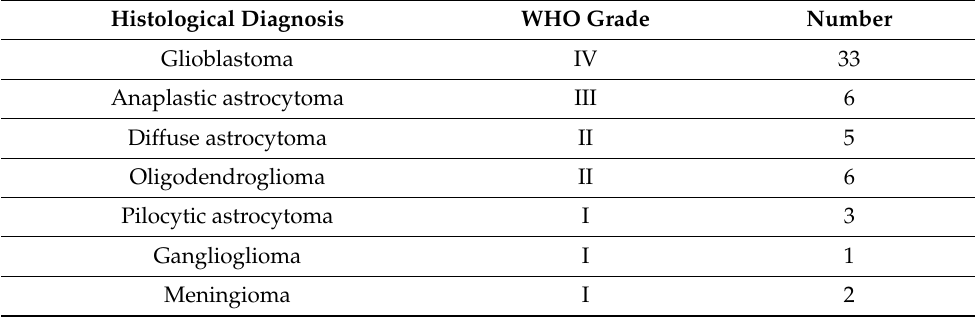
Table 1. Characteristics of population.